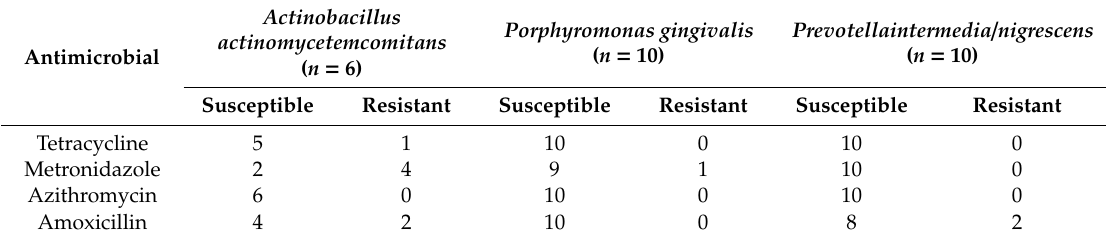
Table 4. Susceptibility of selected bacterial species isolated from periodontal abscess to various antibacterial